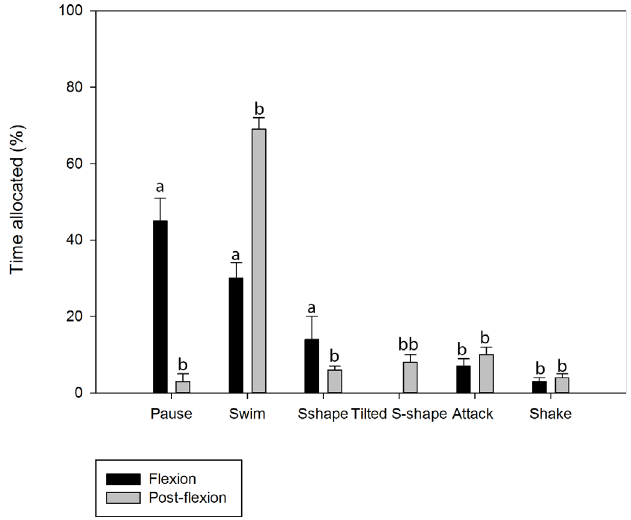
Fig. 2. Percent of time allocated to the MAPs Pause, Swim, S-shape, Tilted S-shape, Attack, Shake. Bars that share the same letter are not signi fi cantly different ( p < 0.05) within each MAP category. Error bars indicate 95% con fi dence